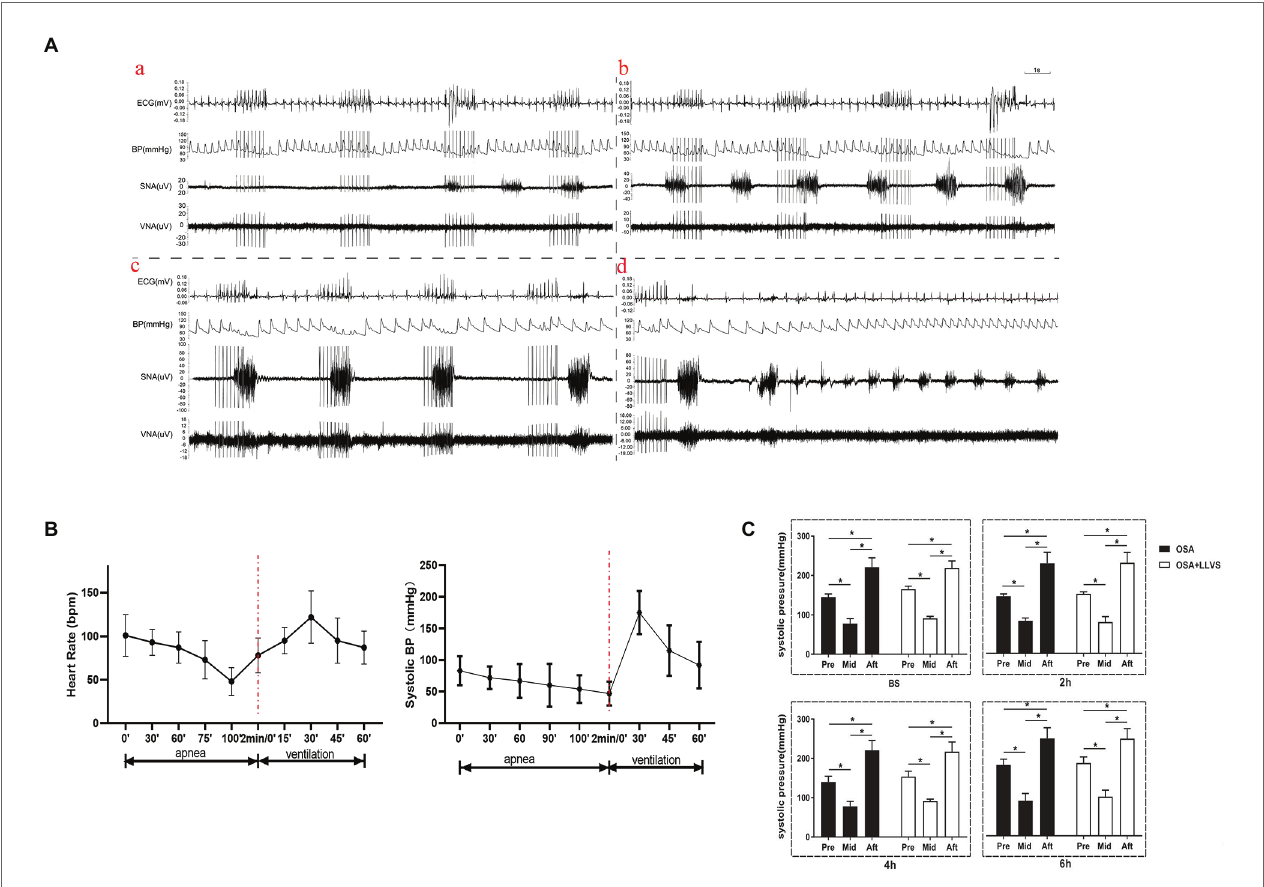
FIGURE 4 | (A) Neural activity recording during the process of apnea and re-ventilation, (a) representative examples of the neural recording at the first 40 s of apnea, (b) representative examples of the neural recording at the second 40 s of apnea, (c) representative examples of the neural recording at the third 40 s of apnea, (d) representative examples of the neural recording at the first 40 s of re-ventilation; (B) The dynamic changes in HR and BP before and after apnea in OSA; (C) Changes in BP pre and after apnea between the OSA and OSA+LLVS groups at baseline, the 2nd hour, the 4th hour, and the 6th hour. * p < 0.05. BS, baseline; H, hours. HR, heart rate; BP, blood